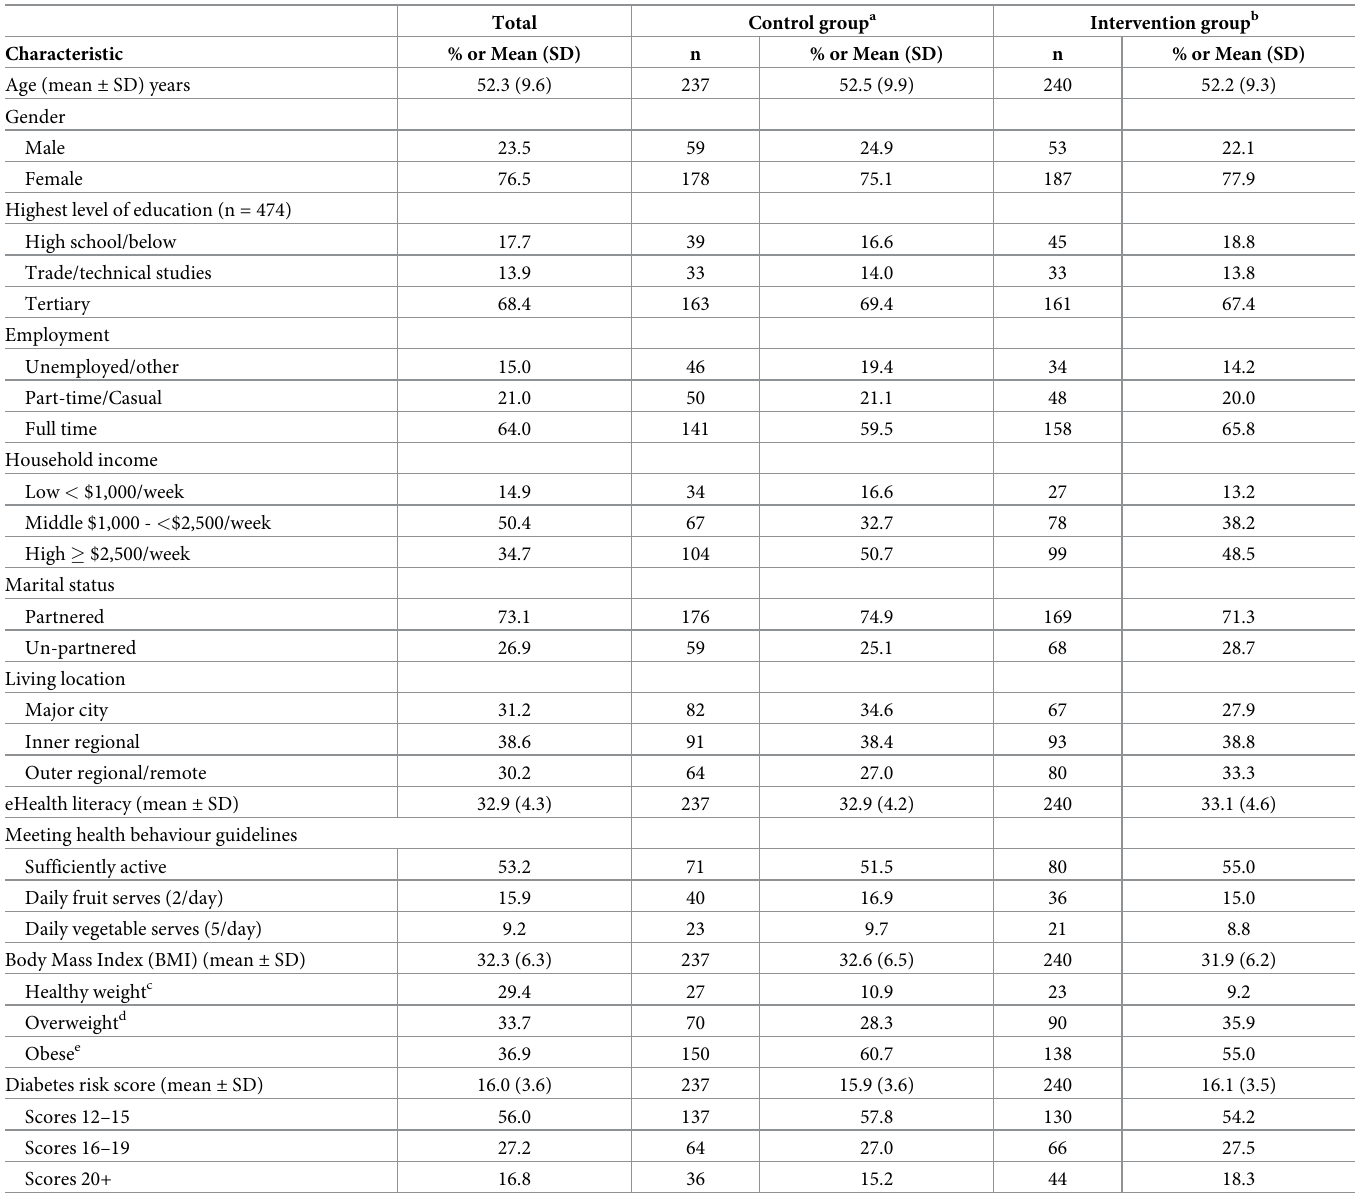
Table 1. Baseline characteristics of participants, by group (N =